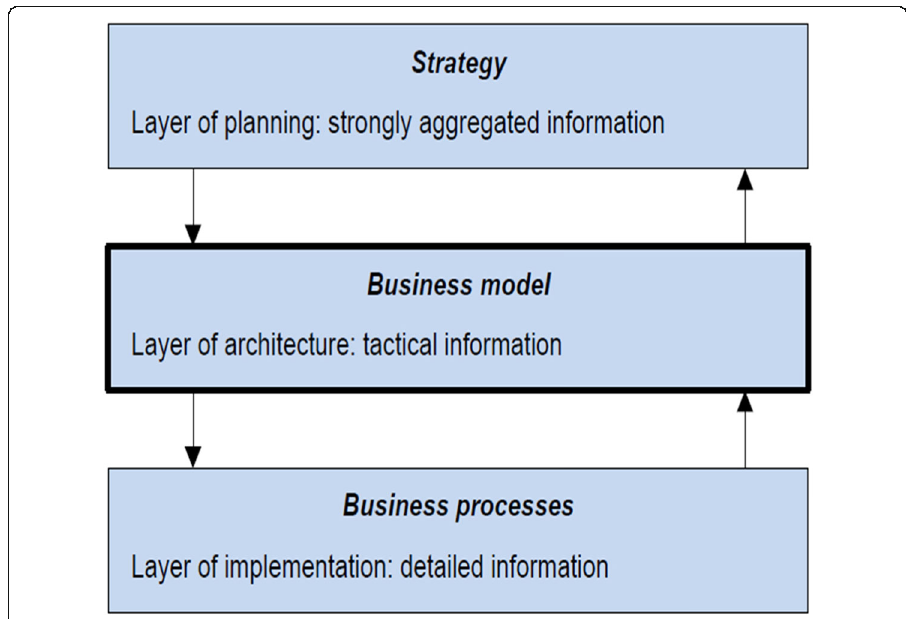
Fig. 5 Business model with process and strategy framework (Samsung White Paper, 2020)